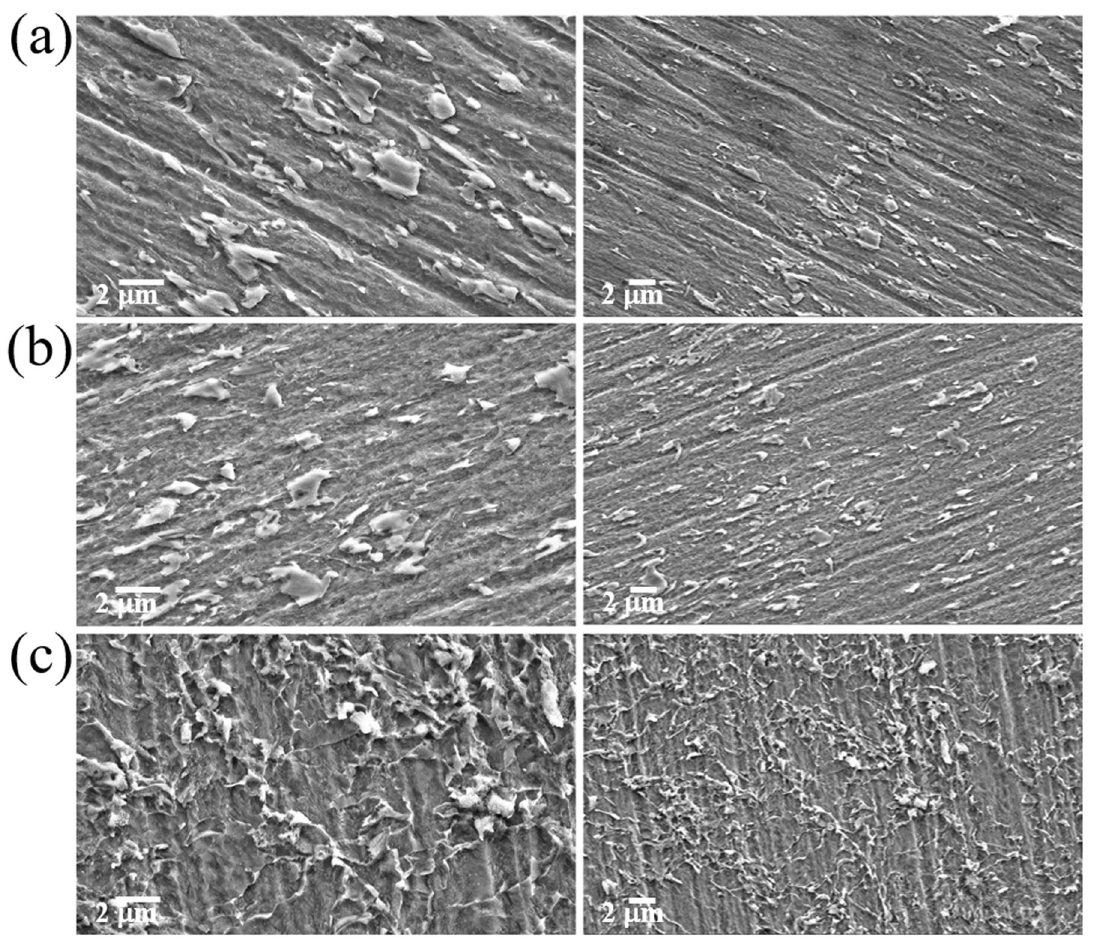
Fig. 6 FESEM images of Vibrio sp. EF187016 EPS on the X80 CS surfaces. a 1 g L − 1 , b 2 g L − 1 , c 3 g L − 1 .